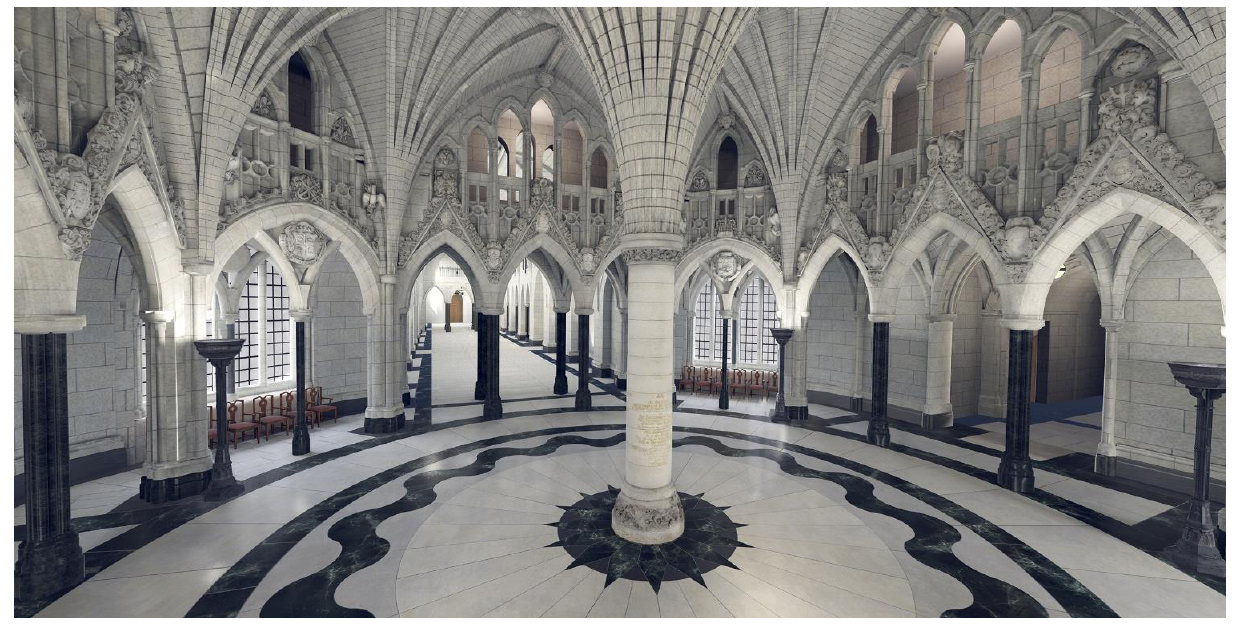
Figure 12: Final VR experience of the Rotunda.